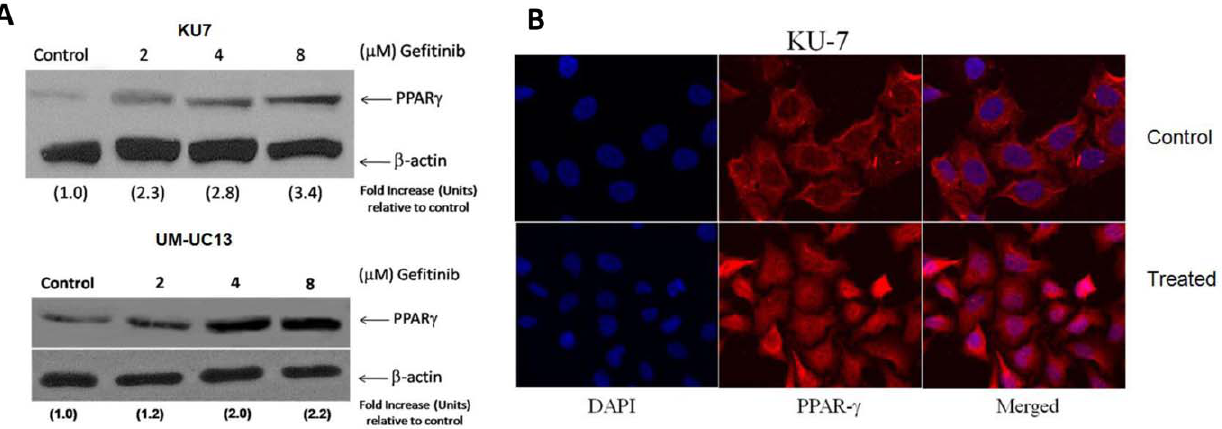
Figure 6. Induction of PPAR c expression in response to different concentrations of gefitinib. (A) Fold increase relative to control was determined after normalization with b -actin as external loading control. (B) Upregulation and nuclear accumulation of PPAR c following treatment with gefitinib (24 hs). doi:10.1371/journal.pone.0055997.g006 PLOS ONE |